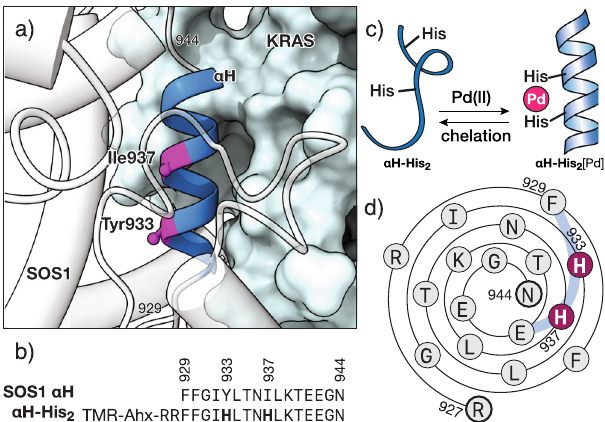
Fig. 1 Design of the metal responsive KRAS peptide inhibitor. a Detail of the α H helix of SOS1 complexed with RAS (PDB code 1BKD) indicating the residues Tyr933 and Ile937 that are replaced by the metal chelating His residues; the structure of SOS1 is shown in white. b Sequence of the natural α H helix of SOS1 and the mutant peptide α H-His 2 used in this study, highlighting the two engineered His residues. c Conformational control by Pd(II) chelation. d Wenxiang diagram of the α H-His 2 79,80 , indicating the residues aligned in the outer face of the α H helix, including the two histidine residues in consecutive turns of the α